Question: Express in one sentence what the figure is showing.
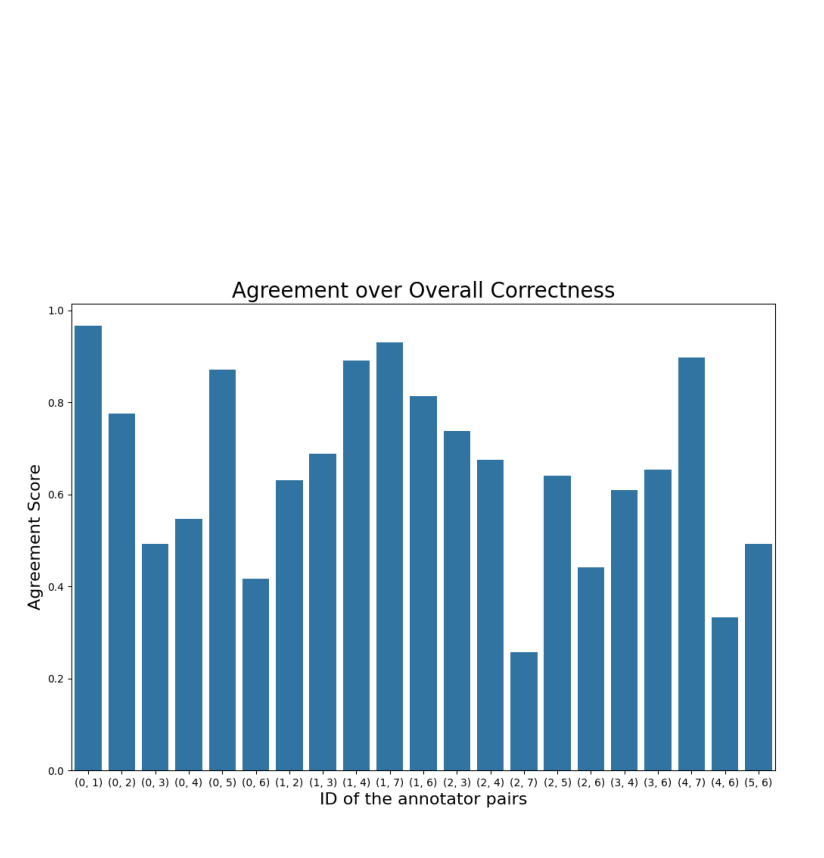
Answer: Annotator Agreement over the Overall Correctness of a given reasoning step